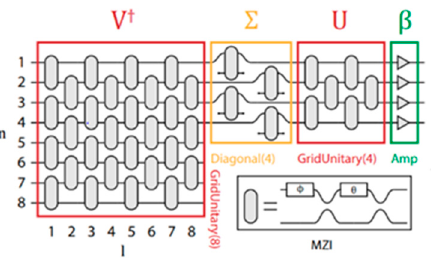
Figure 1. MZI array [20]. A universal 8 × 4 optical linear multiplier with two unitary multipliers marked red. It consists of MZIs in a grid-like layout and a diagonal layer marked yellow.